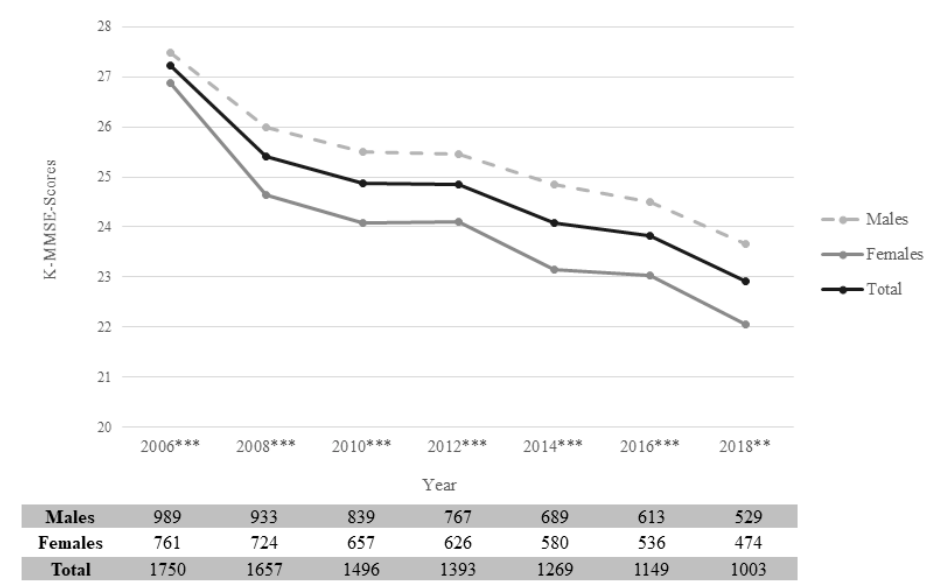
Figure 2. Changes in mean K-MMSE scores and the number of study participants according to sex during the seven waves of the KLoSA. K-MMSE: Korean Mini-Mental State Examination; KLoSA: Korean Longitudinal Study of Aging. ** p < 0.01, *** p < 0.001.